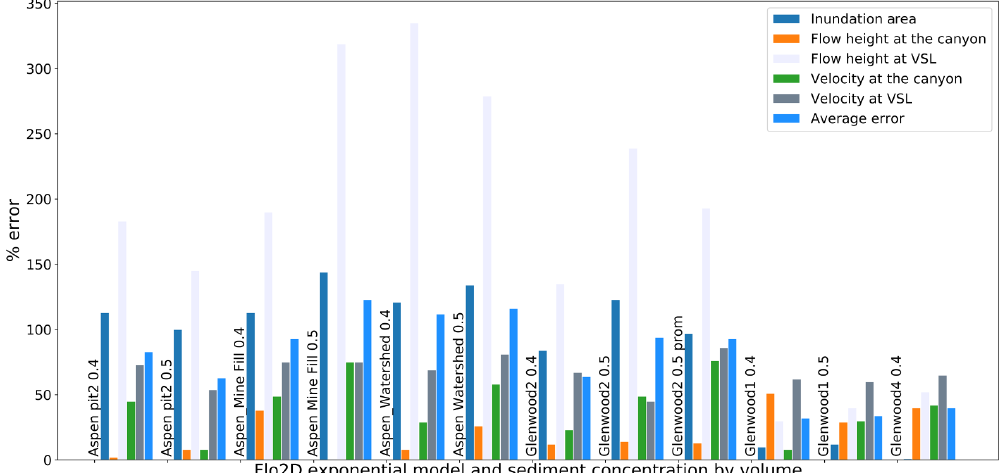
Figure 11. Sensitivity analysis for different dynamic viscosity and shear stress models (VSL: Villa Santa Lucía; FLO-2D,